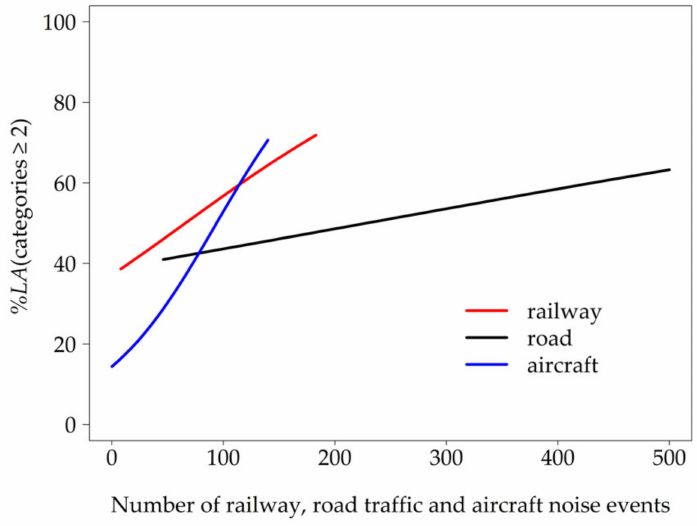
Figure 5. Probability to be annoyed at least a little ( %LA ) depending on the number of nocturnal road traffic, railway, and aircraft noise events expected by model GEE 7 adjusted for general adaptation to chronic noise exposure (median =